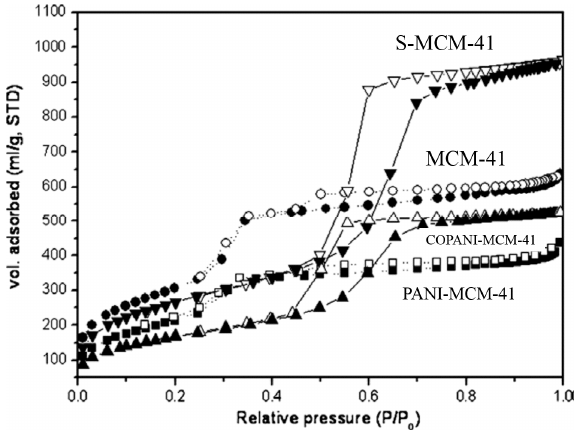
Figure 5. N 2 adsorption-desorption isotherm plots before polymerization, MCM-41 ( ● ) and swollen MCM-41 ( ▼ ); after polymerization, COPANI/swollen MCM-41 ( ▲ ) and PANI/MCM-41 ( ■ ), respectively (Reproduced with permission from [58]. Copyright Elsevier,